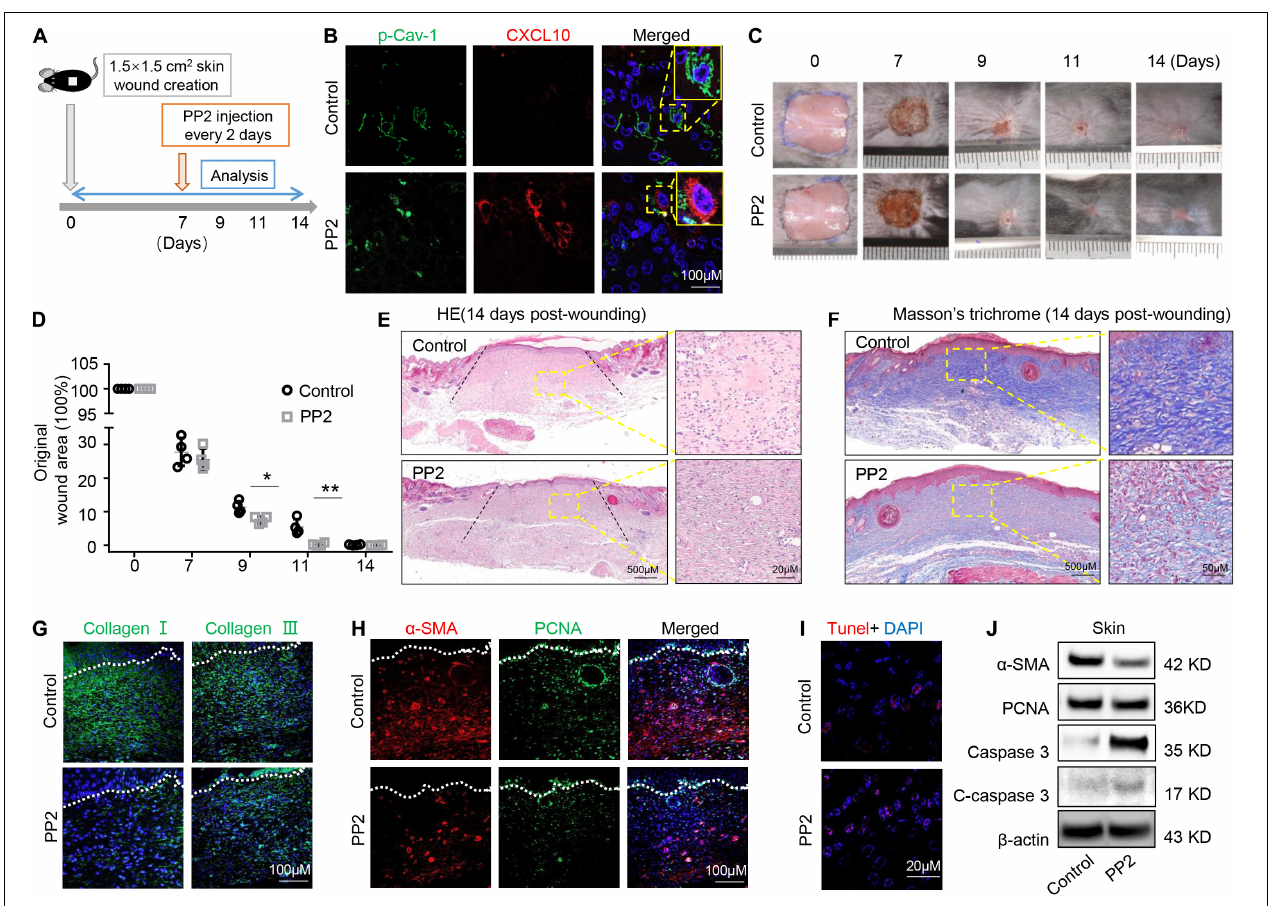
FIGURE 7 | Dephosphorylation of caveolin-1 controls wound healing process in mice. (A) Scheme diagram illustrating the cutaneous wound procedure in C57BL/6 mice and treatment with PP2 or PBS. (B) Immunocytofluorescence staining of p-Cav-1 (green) and CXCL10 (red) in the wound area in control and PP2 treated group. Scale bar, 100 µ m. Magnified images of the boxed region are showed in the upper right boxes. (C) Representative macroscopic images of cutaneous wound area in mice after treatment with and without PP2. (D) Quantification of wound area in mice over time. PP2 treatment could accelerate wound healing process on 9 and 11 days post-wounding compared to WT control mice. * P < 0.05, ** P < 0.01. (E) Representative H&E image from cutaneous wounds in control and PP2 treated mice 14 days post-wounding. Scale bar, 500 µ m. The black dash lines indicate the margin the unhealed wound area. The right box is a higher magnification of the boxed region in the image. Scale bar, 20 µ m. (F) Evaluation of collagen maturity by Masson’s trichrome staining of wounds following treatment with PBS or PP2 at 14 days post-wounding. Scale bar, 500 µ m. The right box is a higher magnification of the boxed region in the image. Scale bar, 50 µ m. Note the bulky collagen fibers in control group. (G) Immunofluorescence analysis showed the expression of Collagen I and Collagen III (green) in the wound area in control and PP2 treated group. Scale bar, 100 µ m. (H) Immunofluorescence analysis showed the staining of α -SMA (red) and PCNA (green) in the wound area in control and PP2 treated group. Scale bar, 100 µ m. (I) TUNEL-positive apoptotic cells (red) in the wound area of PP2 treated group was significantly higher than in the control group. Scale bar, 20 µ m. (J) Western blotting analysis of protein expression of α -SMA, PCNA, caspase 3, and cleaved-caspase 3 in wound